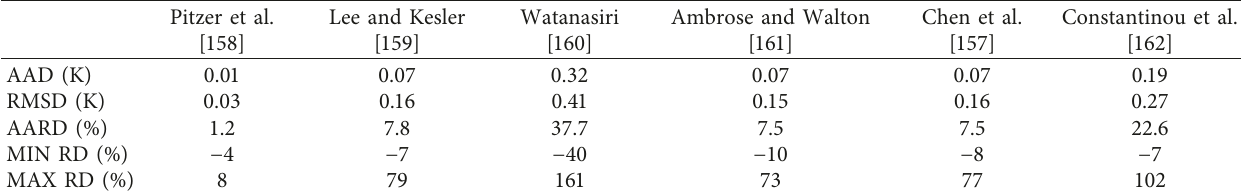
Table 23: Deviations of different methods for the prediction of the acentric factor. Pitzer et al.